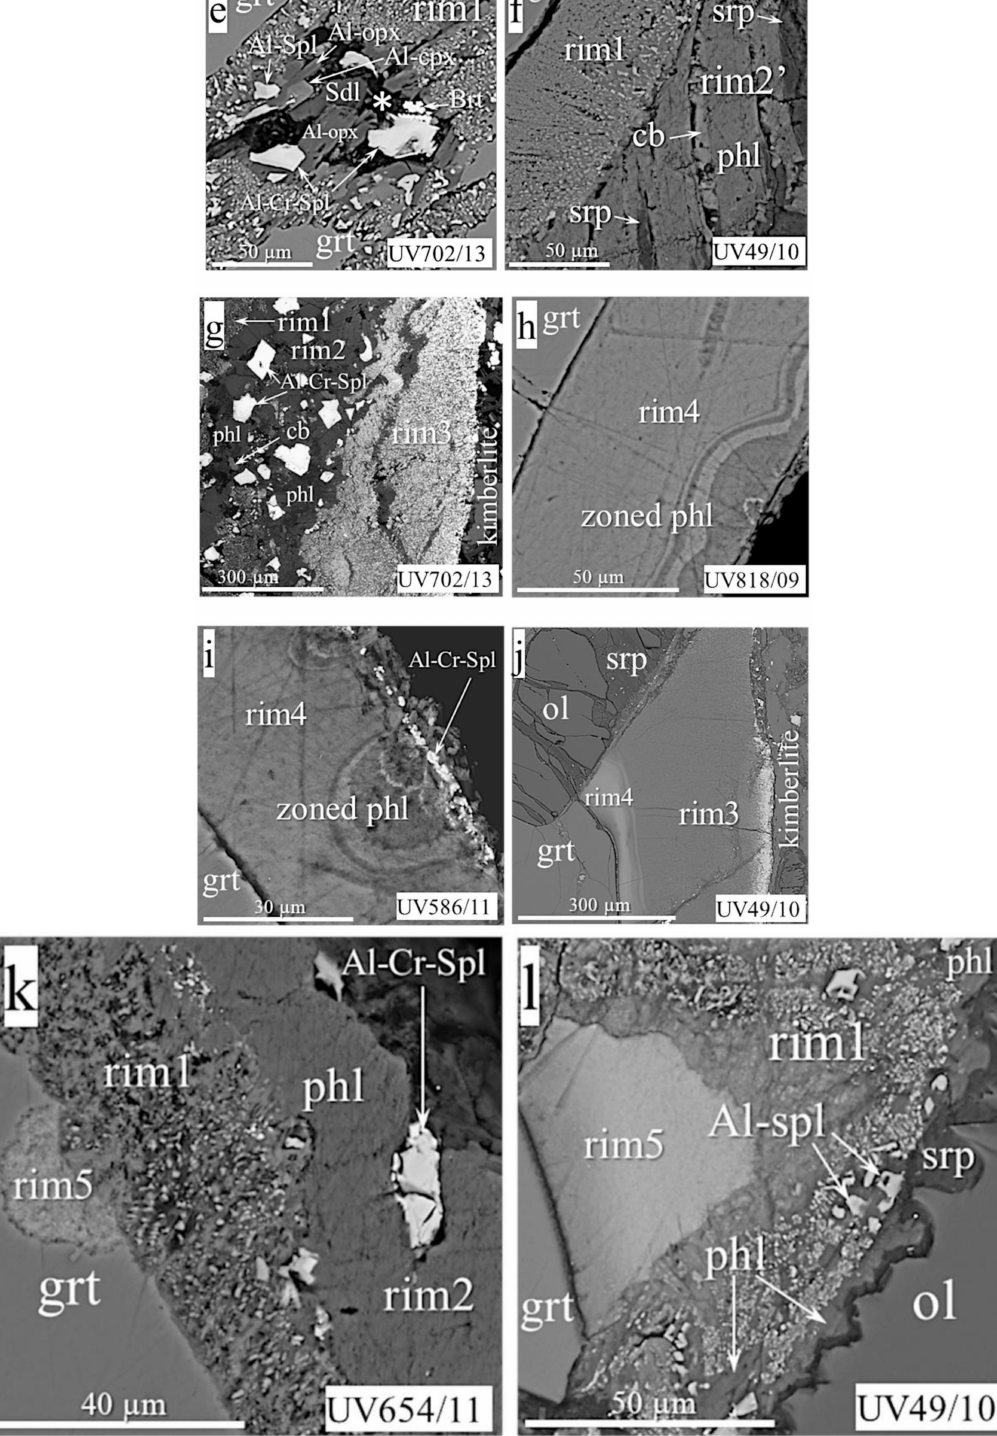
Figure 2. BSE images of the kelyphitic rims on pyropes from MHD: ( a ) Rim1 with mineral grains gradually increasing in the di-rection from the garnet; ( b ) garnet grain relict surrounded by rim1 aggregates; ( c , d ) sharp jump from rim1 to rim2; ( e ) rim1, developing along cracks in a garnet, with a pronounced rim2 spot; ( f ) rim1, sharply bordered on unusual rim2 (rim2 (cid:48) ), consisting of phlogopite, calcium carbonate, and serpentine; ( g ) rim3 develops on rim2; ( h ) rim4 (zoned high chromium phlogopite); ( i ) rim4 with Cr-spinel grains in outer side; ( j ) rim3 develops on rim4; ( k ) rims 1, 2, and 5 (a “pocket” into garnet); ( l ) rims 1, 2, and 5 (a “pocket” into rim1). Asterisks in ( c ) and ( e ) indicate an unidentified hydrous chromium-containing magnesium aluminosilicate with chlorine (see